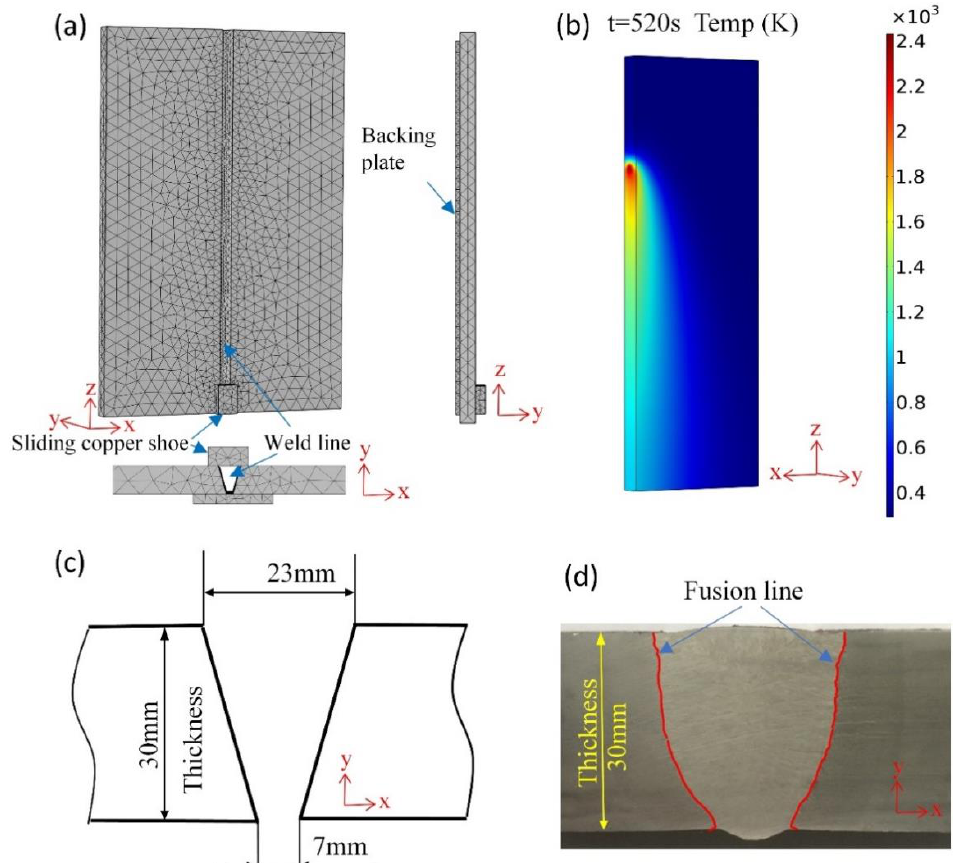
Figure 3. ( a ) Geometry and mesh of EGW model implemented in this study, ( b ) the transient temperature distribution simulated of steel plate at 520 s, ( c ) schematic diagram welding joint of pre-welding bevel, ( d ) welding joint of after-welding showing the fusion line.